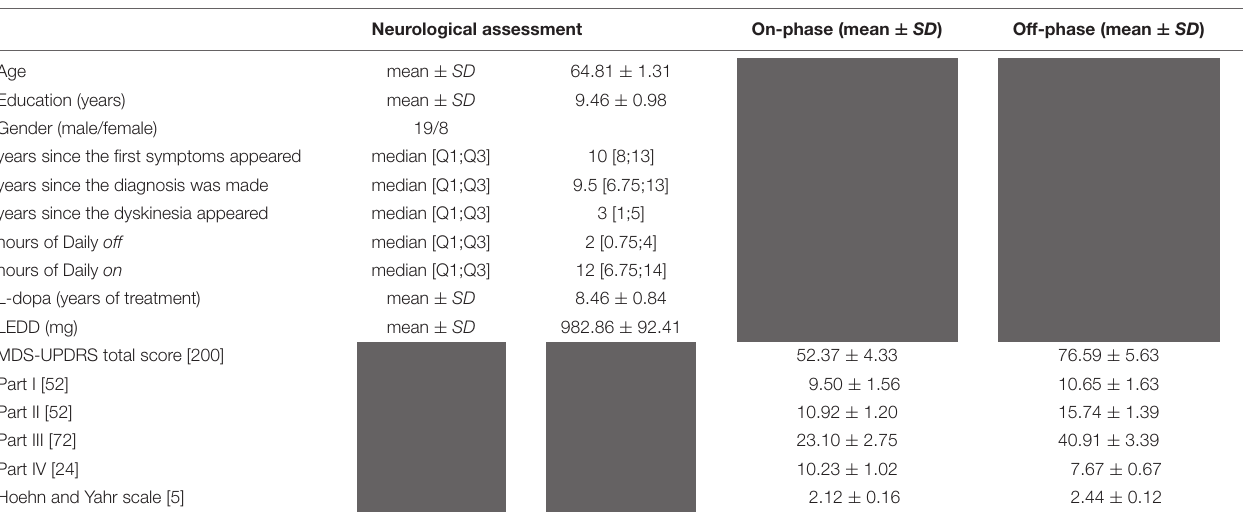
TABLE 1 | Demographic values and motor